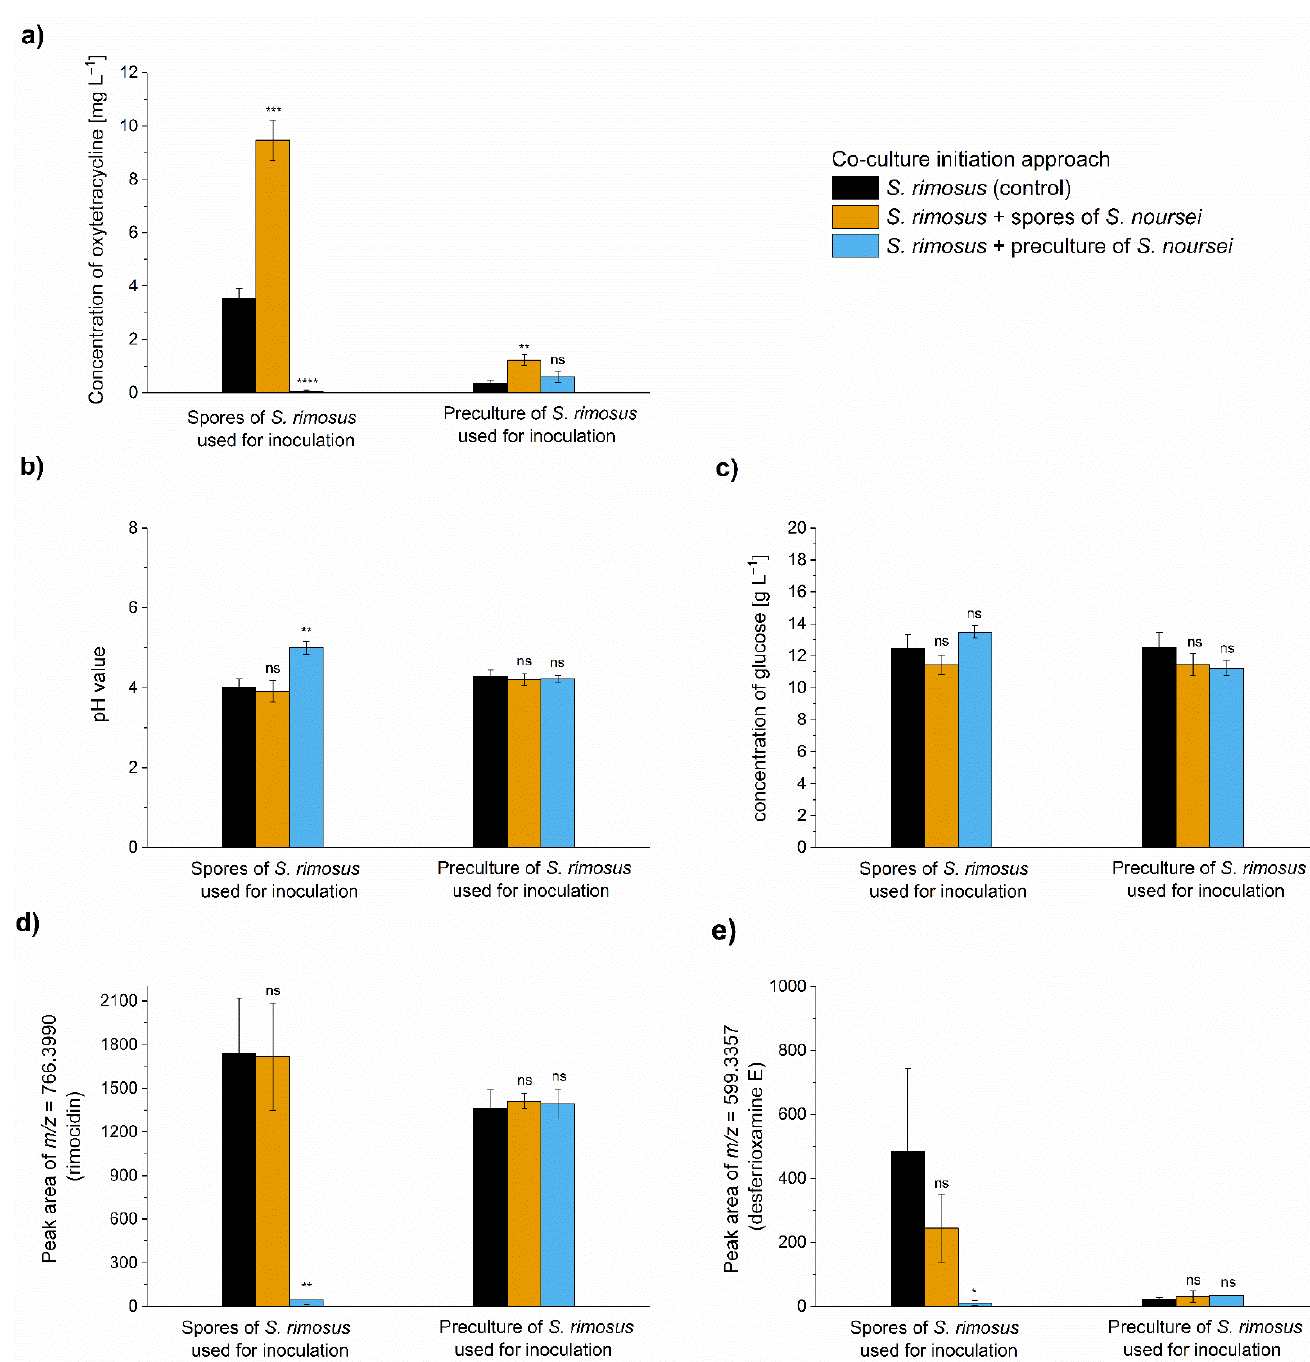
Figure 2. The values of oxytetracycline concentration ( a ), pH ( b ), glucose concentration ( c ), peak area corresponding to rimocidin ( d ) and desferrioxamine E ( e ) after 60 h of submerged co-cultivation of S. rimosus with S. noursei in shake flasks. Several inoculation approaches were tested. The results are given as mean ± SD from three independent experiments ( n = 3). The two-sample t-test was performed to indicate whether the results obtained for the co-cultures differed significantly from the ones recorded for the S. rimosus monoculture controls. * p ≤ 0.05, ** p ≤ 0.01, *** p ≤ 0.001, **** p ≤ 0.0001, n—not significant. The peak areas are given in auxiliary units.